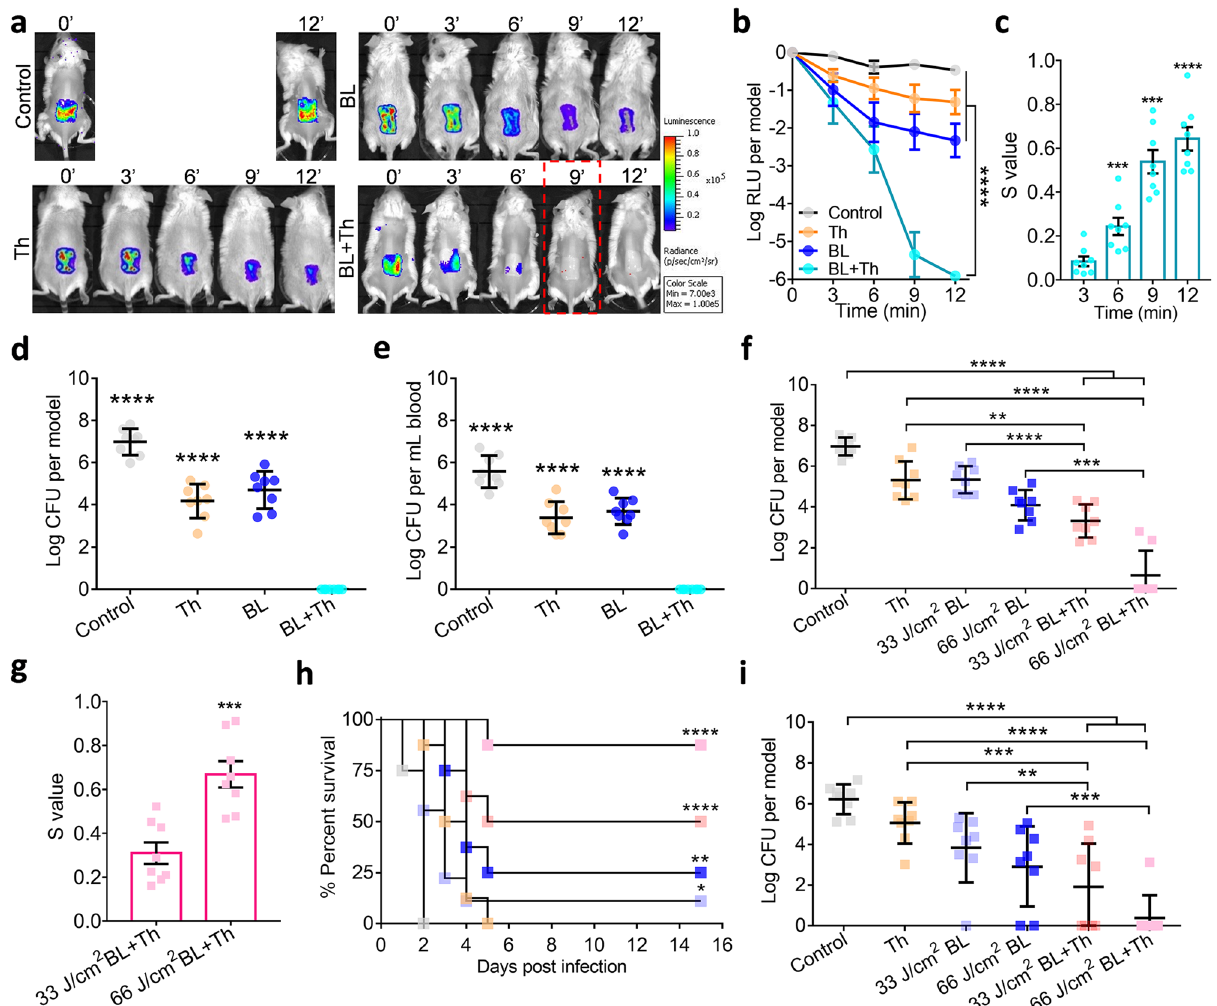
Fig. 3 Synergistic disinfections of murine burns by topical application of BL and thymol. Full-thickness 3rd-burn-wounds were infected with USA300 ( a – e ) or Pa HS0028 ( f – i ) at 5 × 10 6 CFU in 50 μ L of PBS for 30 min as acute infection. a – e The USA300-infected wounds were exposed to sham (control), 50 µ L of thymol at 2 mg/mL (Th), indicated times of BL exposure (BL), or both (BL + Th). a Bacterial luminescence images of representative wounds were acquired at indicated times after various treatments. b Mean luminescence was presented as logarithmic relative luminescence units (log RLU) per model relative to time zero. c S -values are calculated by the Bliss Independence model as Fig. 2. d and e Bacterial burdens in the wounds ( d ) and blood ( e ) were assayed 7 days after acute infection shown as log CFU per model. f – i The Pa HS0028-infected burns were treated with sham (control), 50 µ L of thymol at 10 mg/mL (Th), BL exposure at 33 J/cm 2 or 66 J/cm 2 , or both and log CFU per wound were determined on day 1 after the indicated treatments. g S -values con fi rm the synergy between BL and thymol against acute Pa HS0028 infection. h Kaplan – Meier survival curves of Pa HS0028-infected mice. i Bacterial loads in the burns were quanti fi ed either prior death or at the end of the experiments. All results are presented as mean ± SD of eight mice. Zero in d , e , f , and i was below the detection limit (40 CFU per wound and 20 CFU per mL blood). **** P < 0.0001; *** P < 0.001; ** P < 0.01; and ns, no signi fi